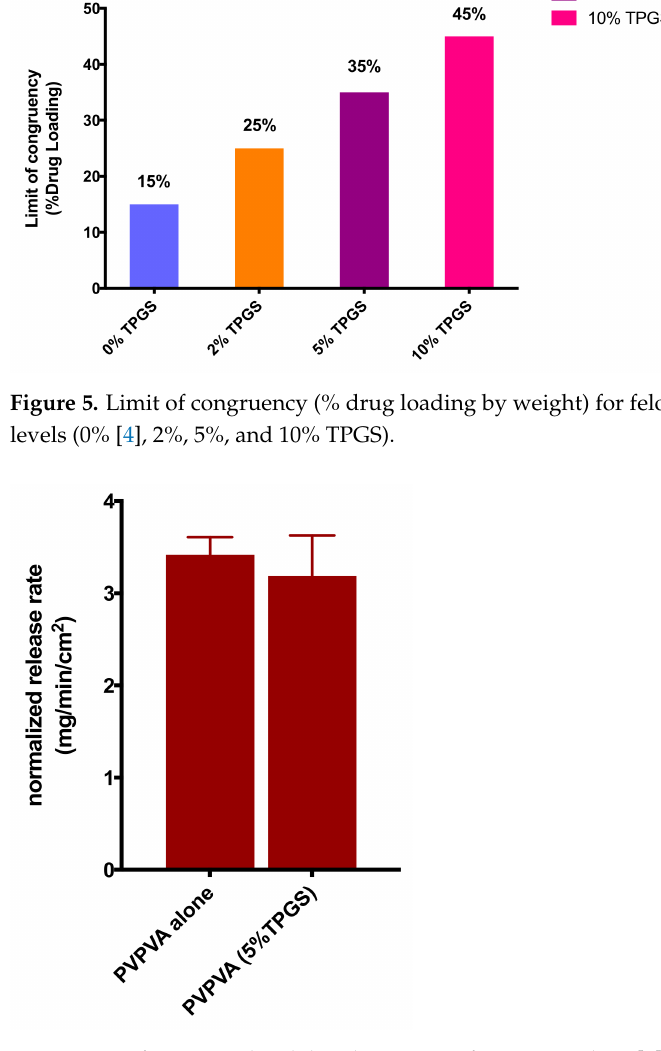
Figure 6. Surface-normalized dissolution rates for PVPVA alone [4] and PVPVA with 5% TPGS. Error bars represent standard deviations, n =